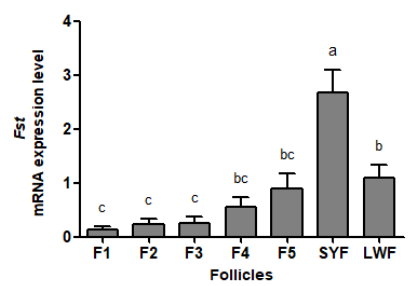
Figure 1. Fst mRNA abundance in the granulosa layers from ovarian pre-hierarchical follicles (SYFs and LWFs) and pre-ovulatory follicles (F1 to F5) in Yangzhou geese ( n = 4). a,b,c represents a significant difference among the means ( p < 0.05). Data represent mean ± SEM.